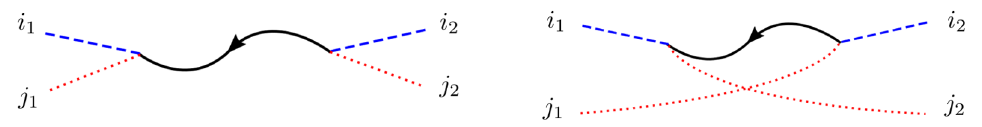
and ρ T 2 . Blue (dashed) lines denote states in R 1 , R 1 R 2 1 R 2